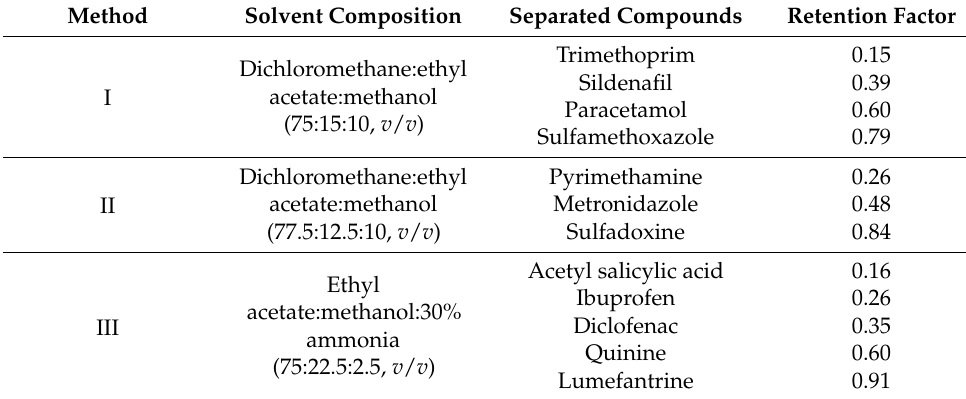
Table 2. Solvent composition, separated compounds, and their retention factors for the developed